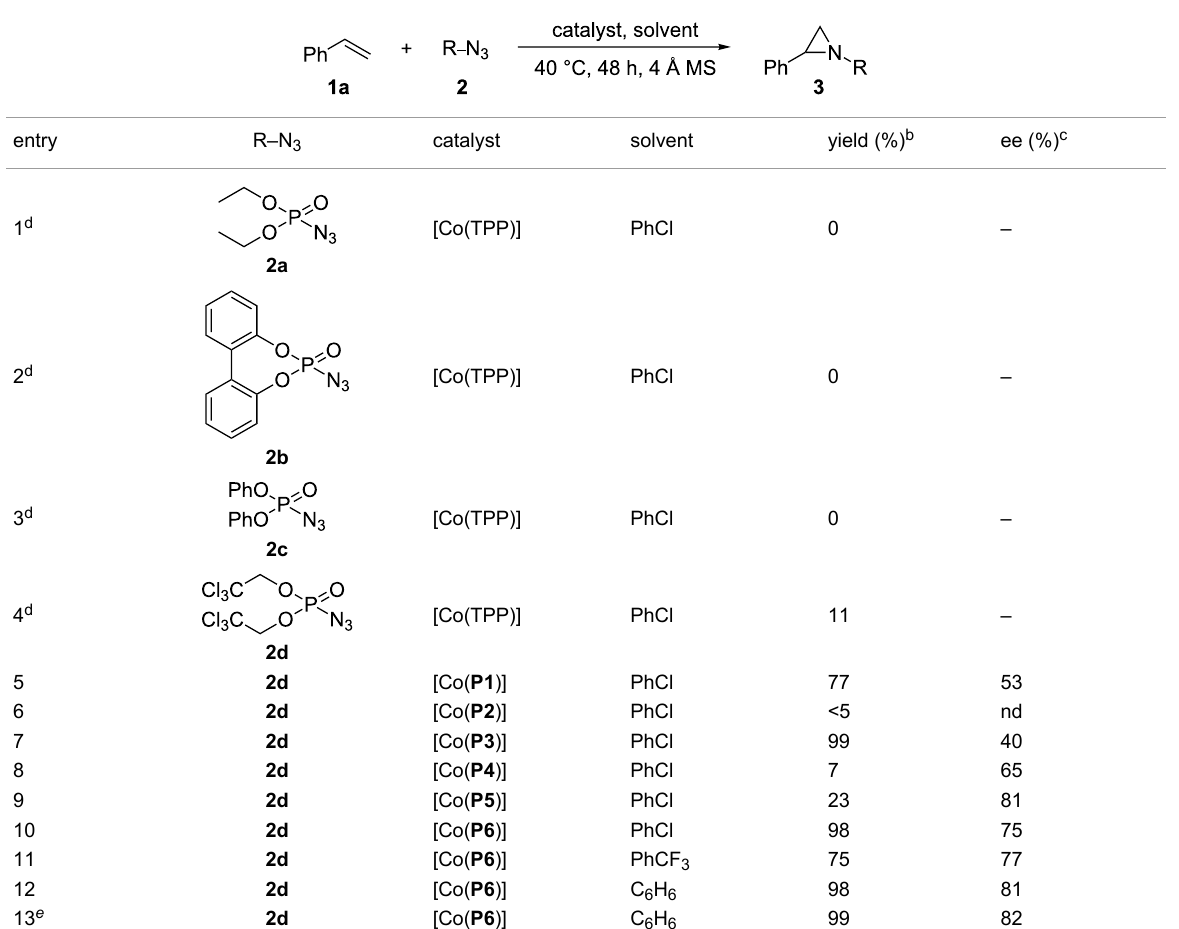
Table 1: Optimization of catalytic aziridination of styrene with phosphoryl azides by Co(II)-based metalloradical catalysts. a